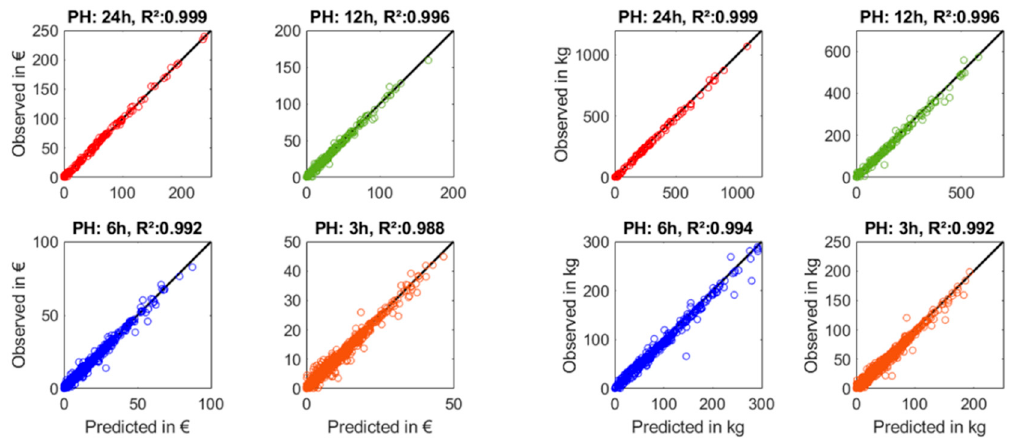
Figure 10. Observed over predicted sum of operating costs ( left ) and CO 2 emissions ( right ) for di ff erent